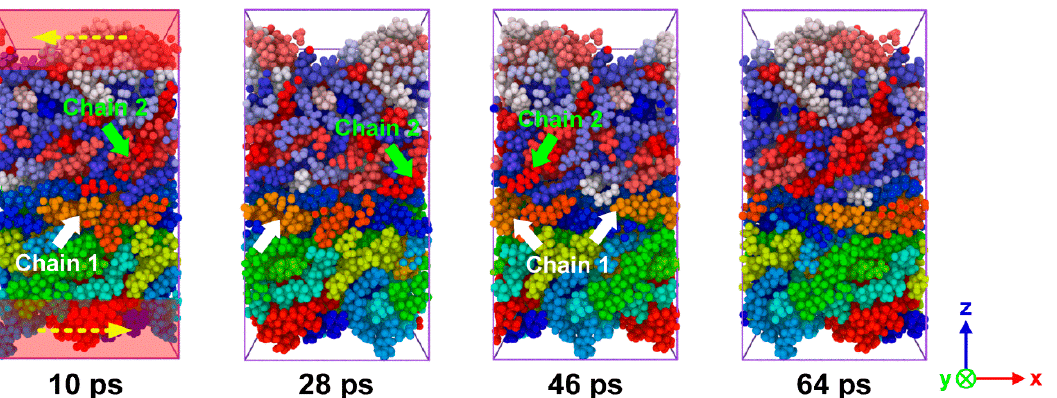
Figure 11. Snapshots of sliding process of the combined PA66–PP interface under T p = 180 °C , T m = 280 °C and P = 4 MPa.